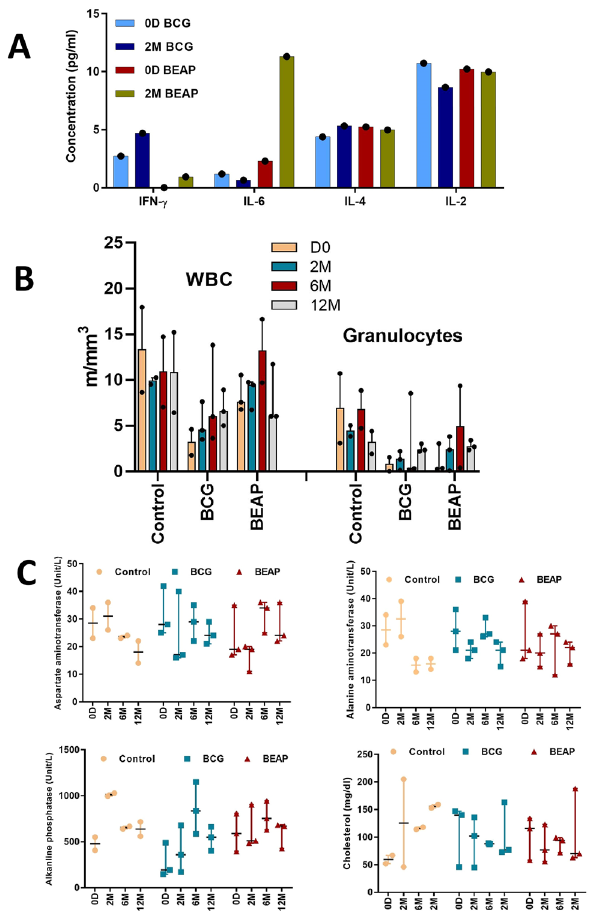
Figure 1. Evaluation of the toxicity or allergenicity of BEAP formulation. ( A ) Cytokine levels in the serum of BCG/BEAP immunized adult animal on D0 and at 2 months post immunization, ( B ) The granulocytes and WBC count in the control and post immunized infants. ( C ) Levels of liver secreted enzymes aspartate aminotransferase (AST), alanine aminotransferase (ALT) alkaline phosphatase (ALP) and cholesterol in the control and BCG/BEAP immunized infants at different time points. Dots indicate data points and bars are median with 95% confidence interval. Graphs were plotted using GraphPad Prism version-7 program (https :// www.graph